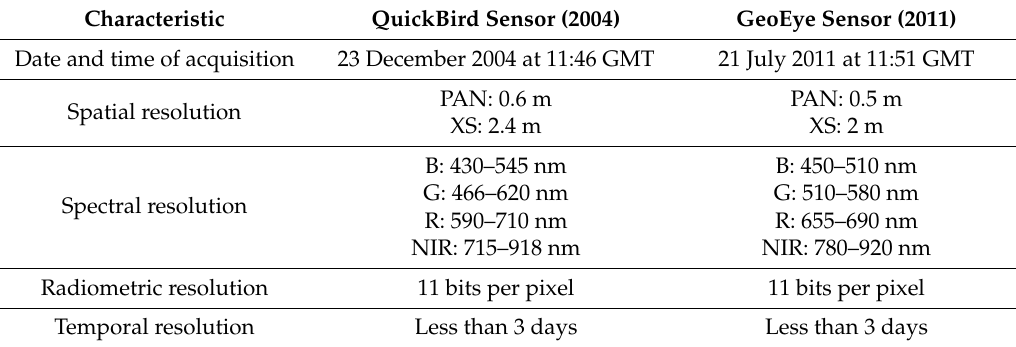
Table 1. Resolution specifications of the satellite images. PAN refers to the panchromatic band and XS to the multispectral bands. B refers to blue, G to green, R to red, and NIR to